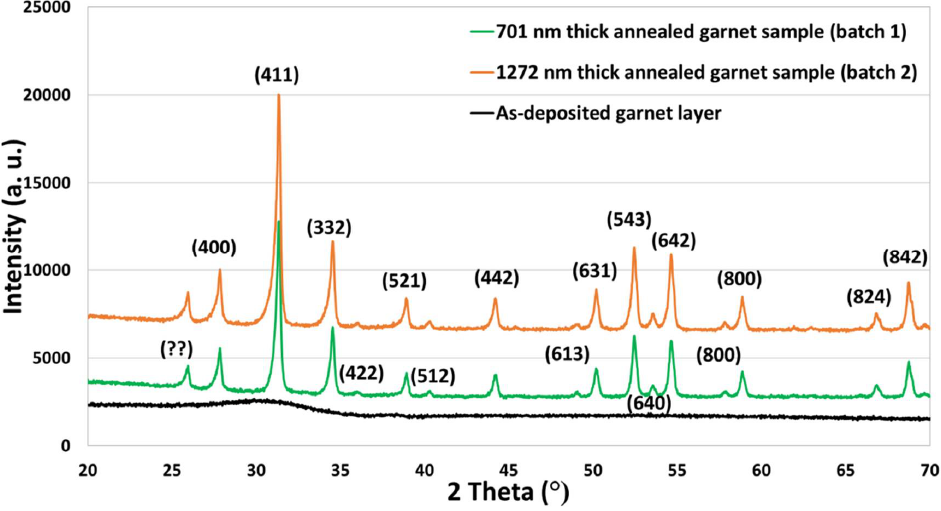
Figure 2. X-ray diffractograms of as-deposited and annealed garnet layers.